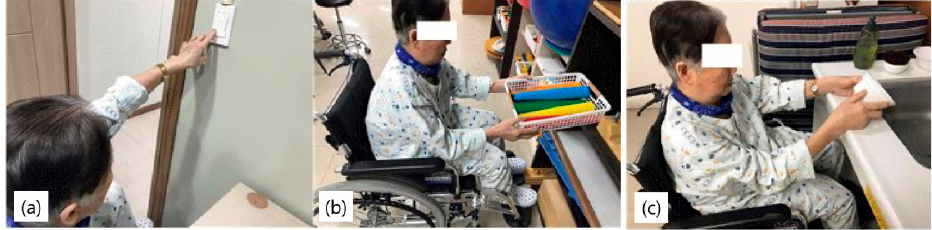
Figure 4. Intervention in the normal bilateral arm training group. ( a ) turning on lights, ( b ) organizing drawers, ( c ) arranging a kitchen.